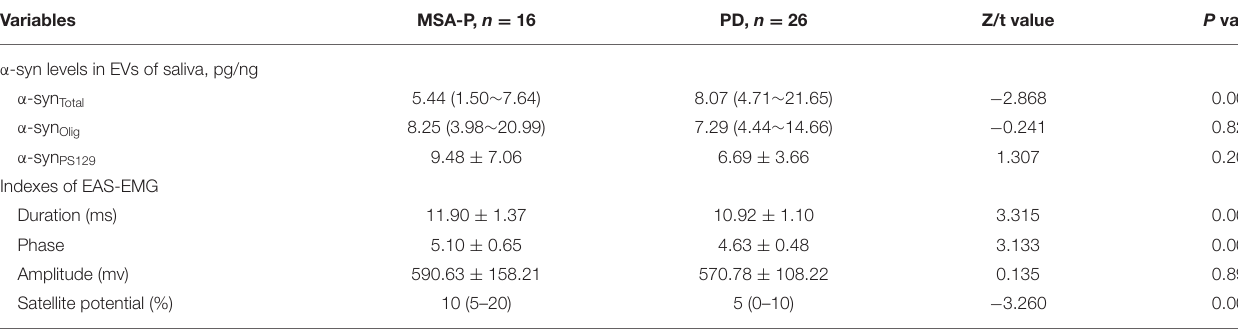
TABLE 2 | The α -syn levels in EVs of saliva, indexes of EAS-EMG between MSA-P and PD. Variables MSA-P, n = 16